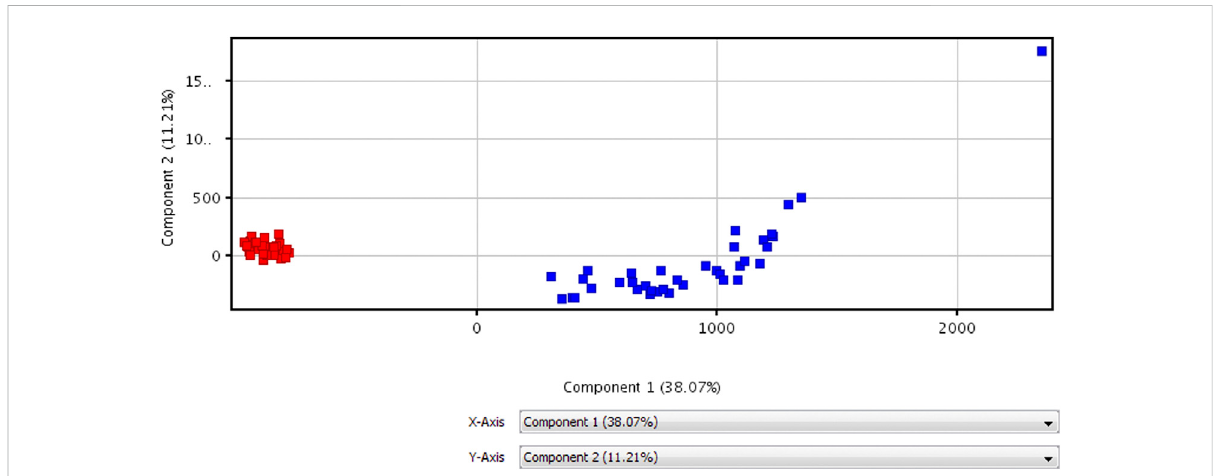
out according to PCA diagram (see Figure 2 for details), volcano plot diagram (see Figure 3 for detials), hierarchical cluster analysis (see Figure 4 for details), and t -test.